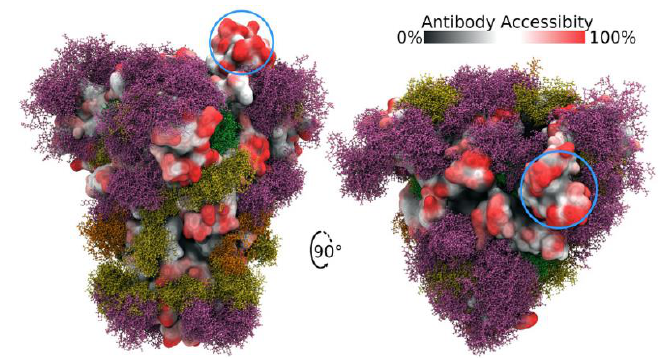
Figure 2. Side and top views of Spike trimer with site-specific glycosylation shown (moss surface) from molecular dynamics simulations [23]. The glycans are shown in ball-and-stick representation in green, dark yellow, orange and pink. The protein surface is colored according to antibody accessibility from black (least) to red (most accessible). One RBD is shown in the open conformation (circled in blue). Images are from [23] and are used under Creative Commons Attribution 4.0